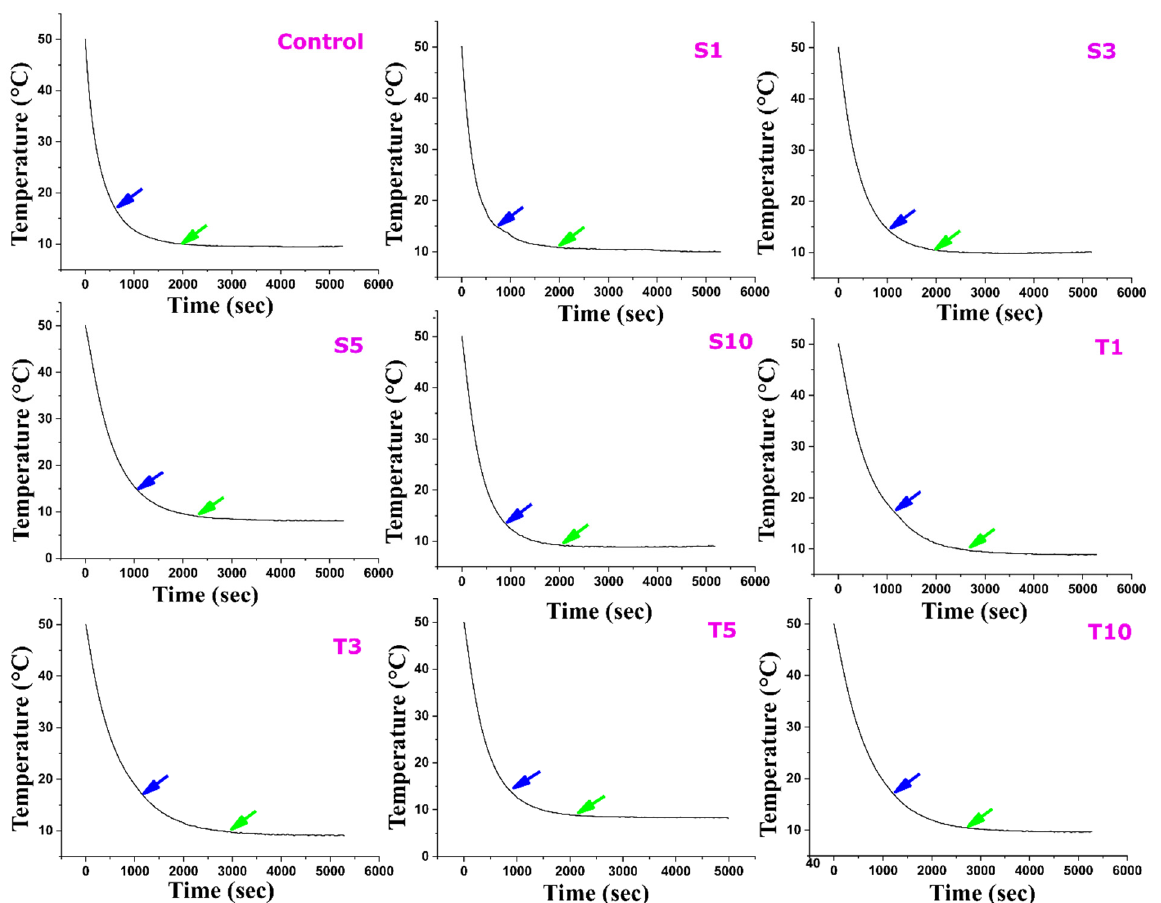
Figure 10. Gelation kinetics of all the formulations. (Blue arrow: onset of secondary crystallization (s), Green arrow: time to reach thermal equilibrium (s). The details of abbreviations used are provided in Section 4.2 (Table 5). Table 3. Parameters obtained through exponential decay modelling of gelation kinetics of formulation. Temperature vs. Formulations